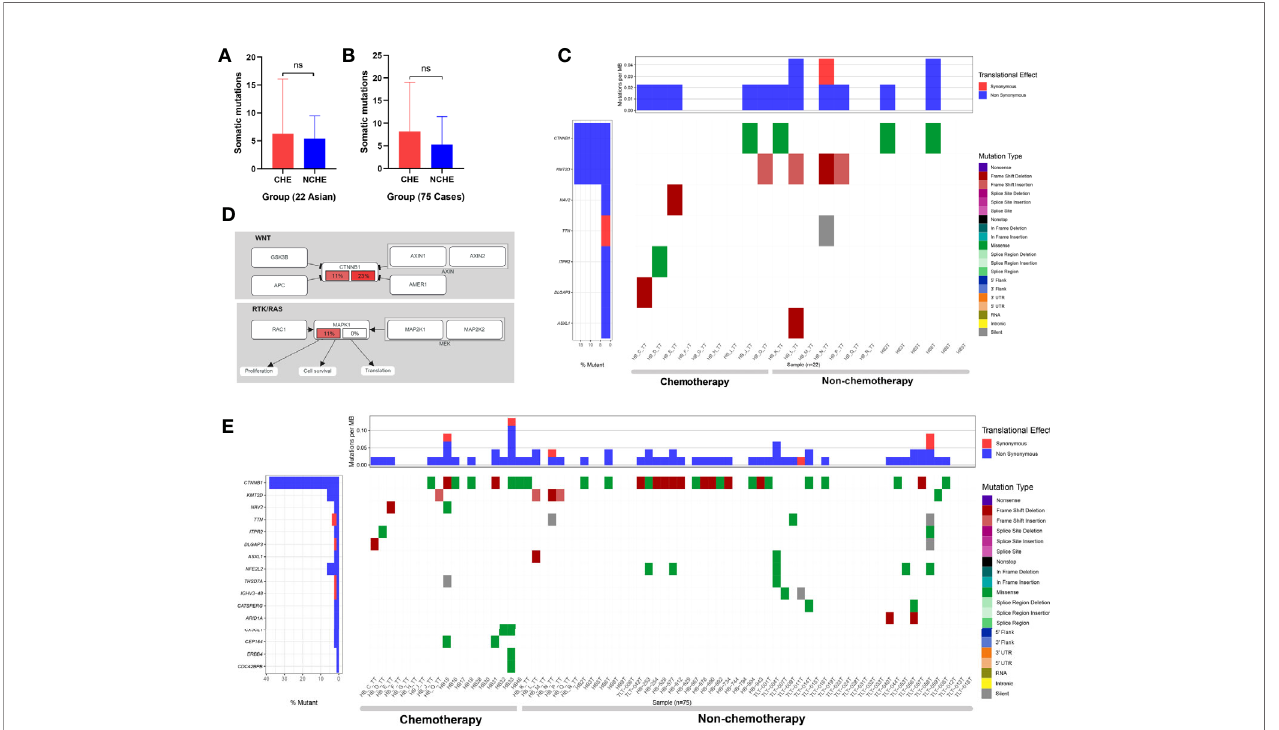
FIGURE 5 | Somatic mutations of HB in the nonchemotherapy group (NCG) and chemotherapy group (CG) before operation. (A) Comparative analysis of the somatic mutation number of 22 cases (from Asian) of hepatoblastoma samples from the NCG and CG before surgery (ns means P = 0.785, Mann-Whitney U test). (B) Comparative analysis of somatic mutation numbers of 75 cases of hepatoblastoma samples from the NCG and CG before operation (ns means P = 0.17, Mann-Whitney U test). (C) Somatic mutations of 22 hepatoblastoma patients in the NCG (13 patients) and CG (9 patients) before surgery. The heatmap displays the landscape of recurrently mutated genes in hepatoblastoma. The central heatmap shows the mutation status of the recurrently mutated genes for each tumor. Somatic mutations are colored according to functional class (right). Left, mutation count for each individual gene. (D) Oncogenic network in hepatoblastoma (22 Asian patients). The fraction of mutated samples within the preoperative NCG and CG is shown in the left and right portions of each rectangle. (E) Somatic mutations of 75 hepatoblastoma patients in the NCG (56 patients) and CG (19 patients) before surgery. The heatmap displays the landscape of recurrently mutated genes in HB. The central heatmap shows the mutation status of the genes with recurrent mutations for each tumor. Somatic mutations are colored according to functional class (right). Left, mutation count for each individual